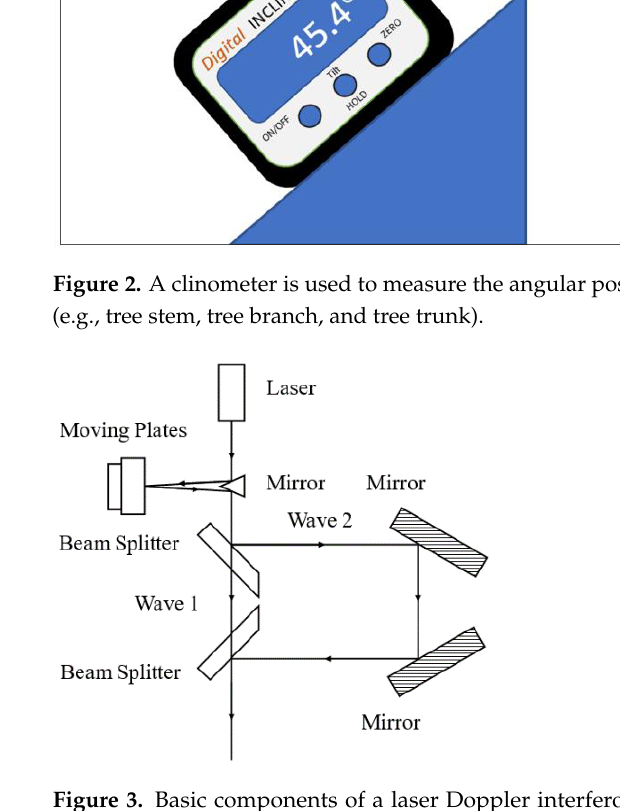
Figure 2. A clinometer is used to measure the angular position of the aerial parts of the sample tree (e.g., tree stem, tree branch, and tree trunk).